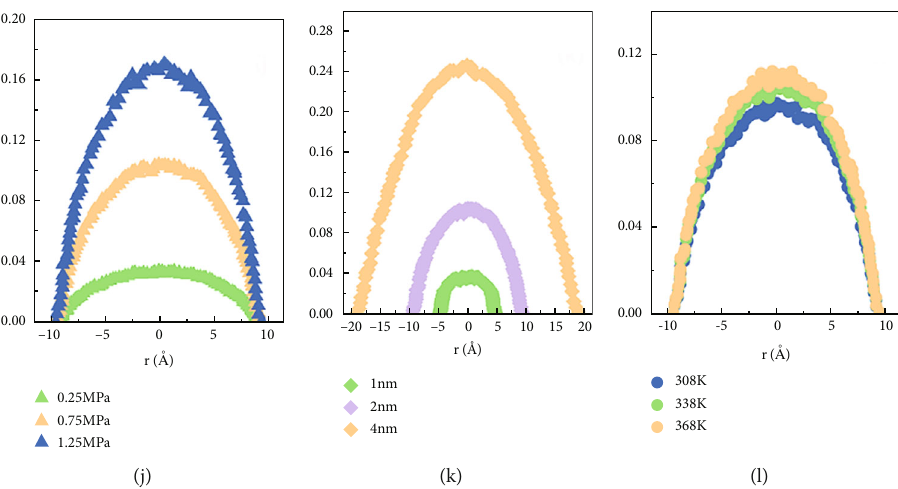
Figure 7: Velocity distribution of CH in shale organic nanopores under di ff erent conditions. Type I: (a − d), Type II: (e − h), Type III: (i − l). 4 Pore pressure (a, e, and i), pressure drop (b, f, and j), pore size (c, g, and k), and ambient temperature (d, h, and l).